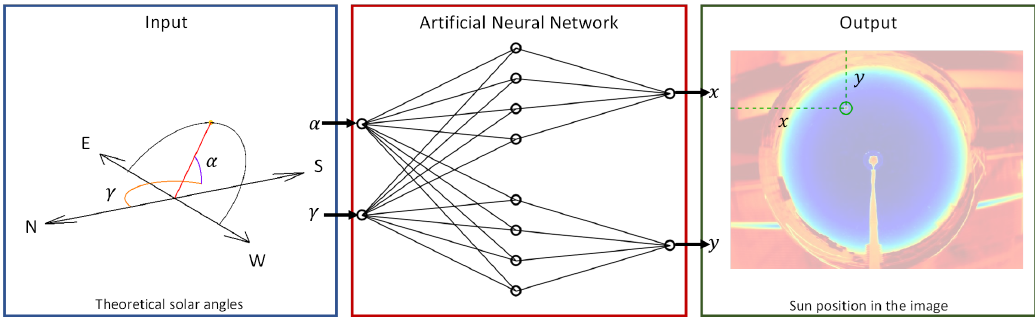
Figure 12. Working principle scheme of the neural network-based identification method: the network receives as inputs the azimuth and the elevation and returns as outputs the the x- and y-coordinates of the Sun on the